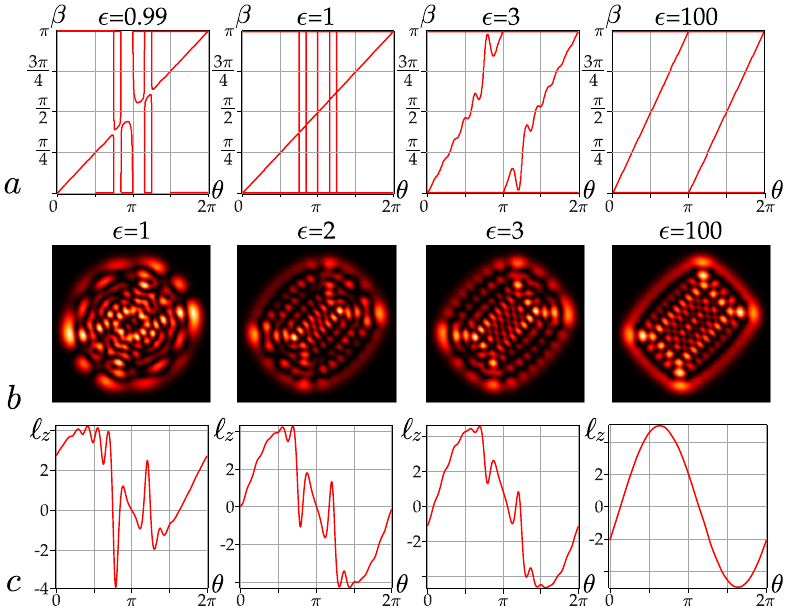
Figure 5. ( a ) Invariants of a simple astigmatism at different amplitude parameters (cid:101) ; ( b ) intensity distribution of the asLG beam with ( n , (cid:96) ) = ( 5,5 ) at different amplitude parameters (cid:101) and ( θ , β ) = ( 1,0.5 ) ; ( c ) the OAM (cid:96) z ( θ ) of the asLG beam for some values of (cid:101) and β = π